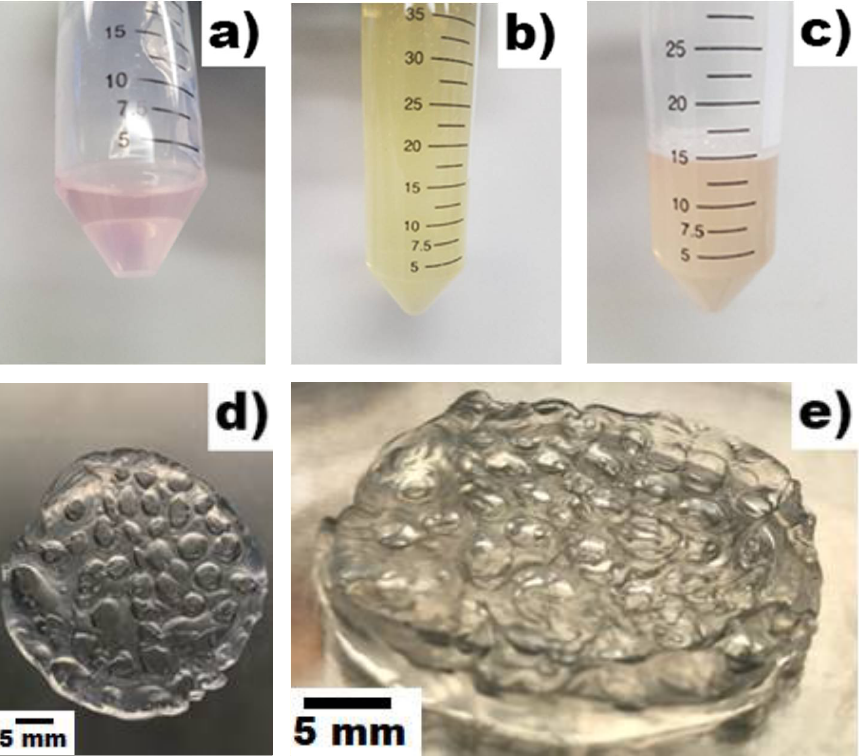
Figure 1. Reference images for EWA protocol : ( a ) Image of alginate (2%) dissolved in Epi Max medium. ( b ) Image of extracted EW. ( c ) Image of egg white and alginate mixed together post-centrifugation forming froth layer on top. ( d ) Image of EWA from top view, illustrating the air bubbles and craters created post-crosslinkage. ( e ) Close image of EWA to illustrate the topography, texture, and thickness of the scaffold